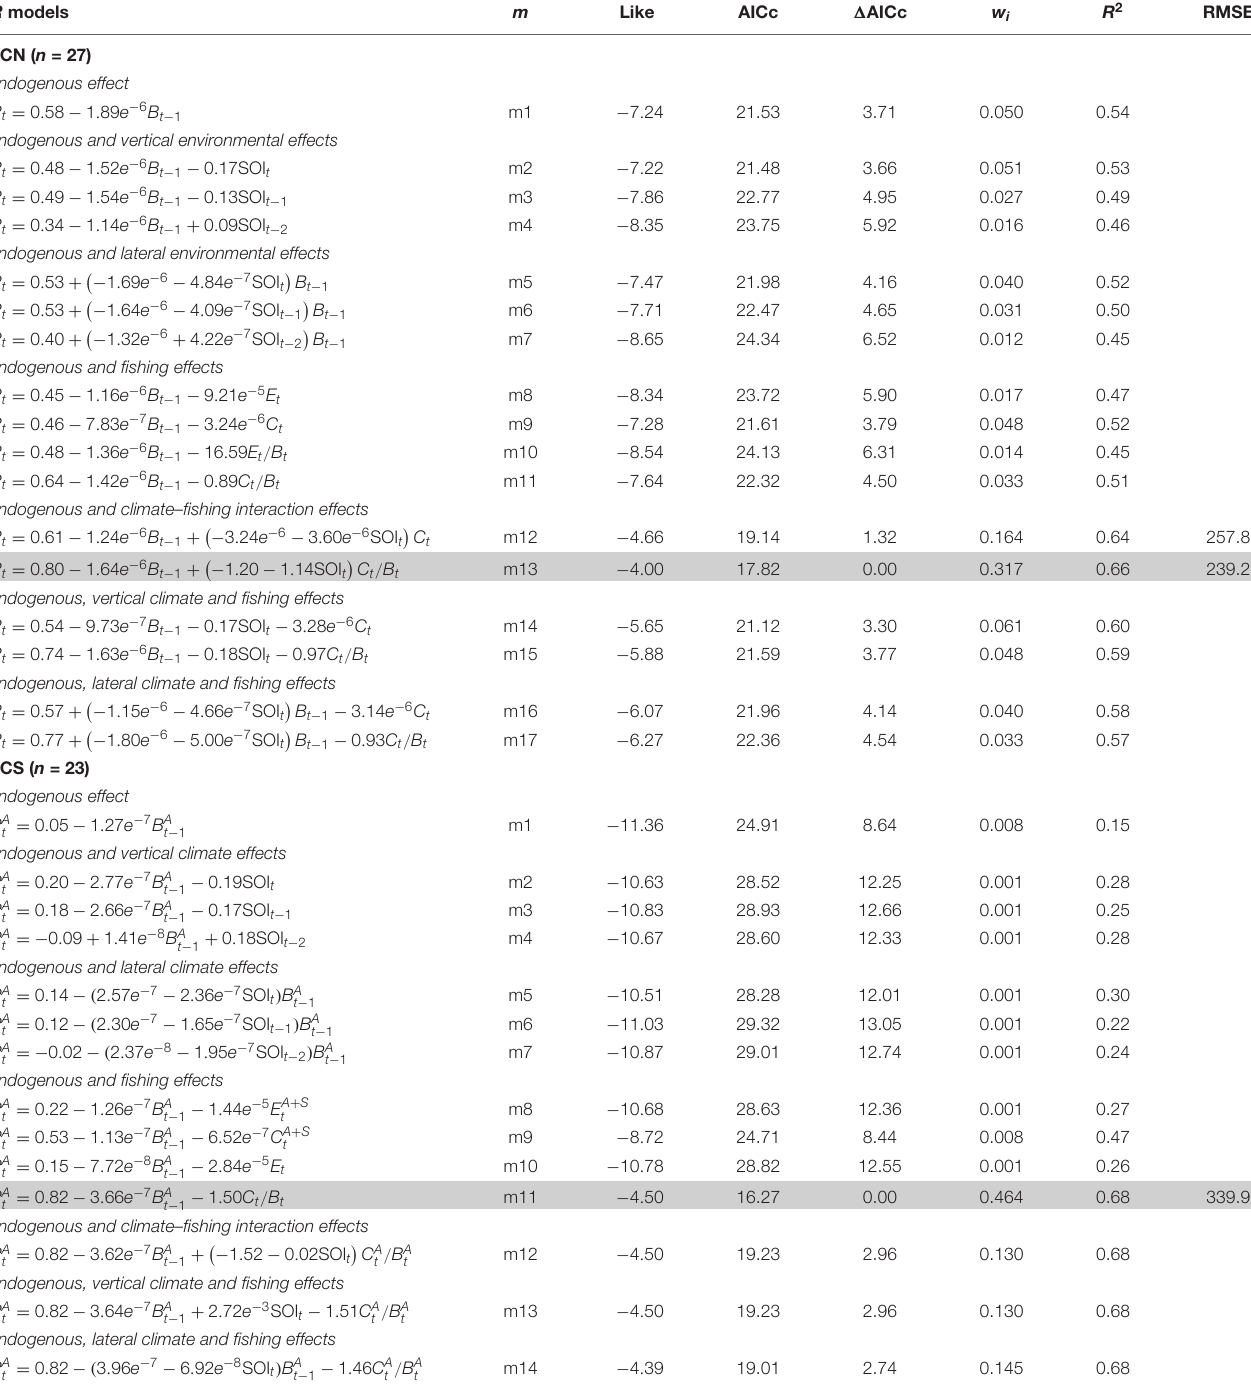
TABLE 2 | Population dynamics models for the anchovy stocks ( Engraulis ringens ). R models m Like AICc (cid:49) AICc w i R 2